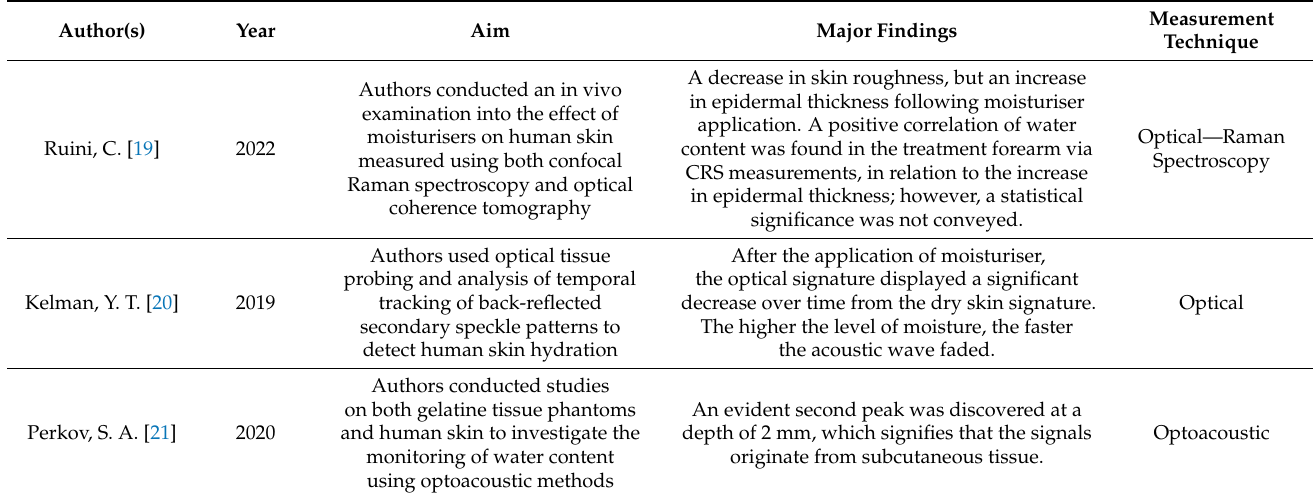
Table A1. Studies for the measurement of skin hydration using optical